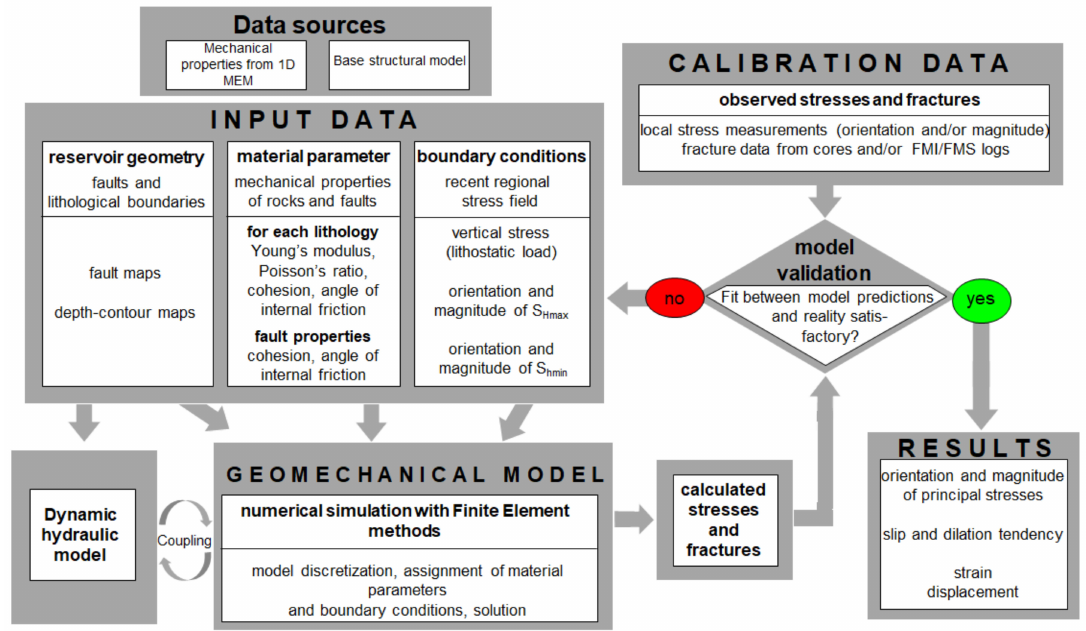
Figure 3. 3D geomechanical modeling workflow including input data sources, validation and calibration. Modified after Henk et al. [7]. If model validation fails, revised input parameters considering uncertainties in measurements have to be taken into account for the next model’s